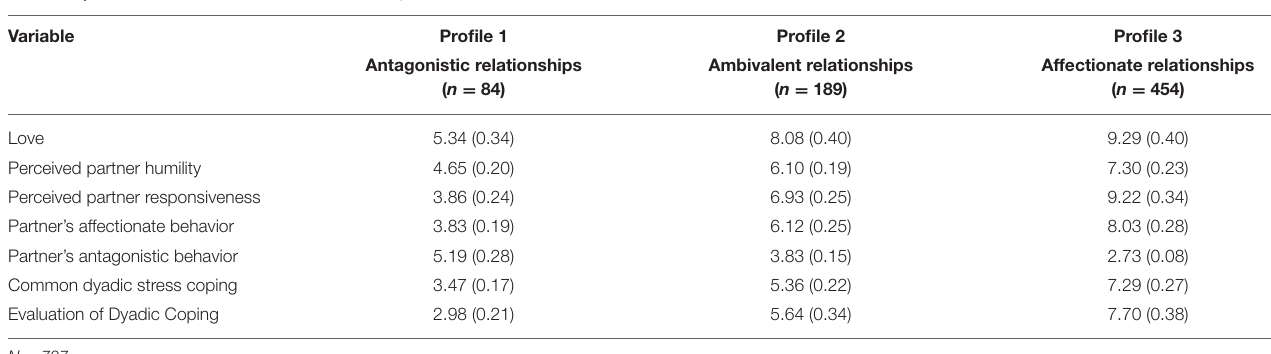
TABLE 4 | Means and standard values for the three profiles.